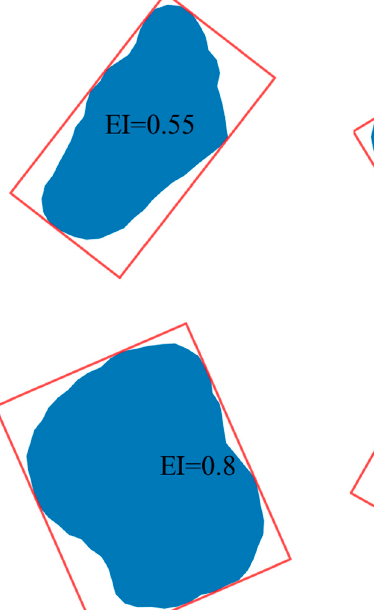
Figure 6. Particles with different roundness.